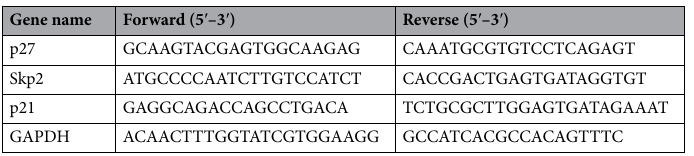
Table 1. Primer sequences of the genes for